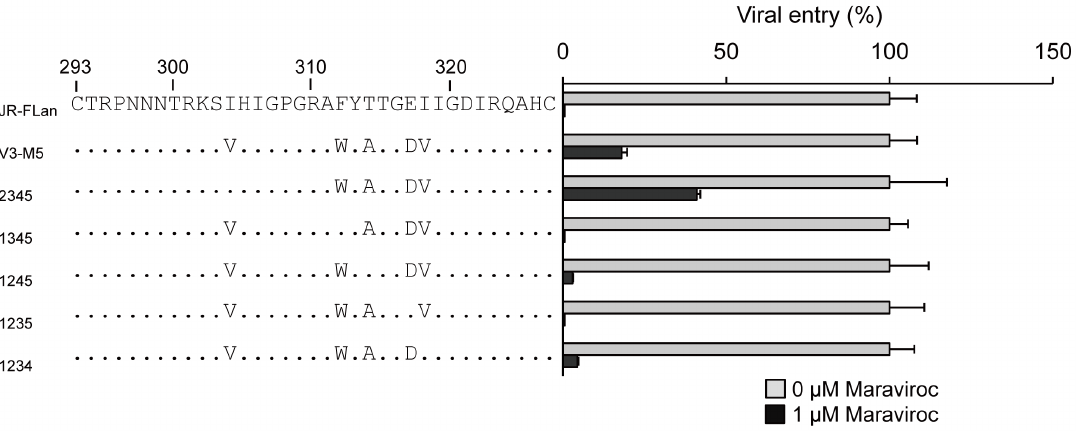
Figure 6. Maraviroc susceptibility of pseudotyped viruses derived from HIV-1 JR-FLan , HIV-1 V3-M5 , HIV-1 2345 , and HIV-1 1345 , HIV-1 1245 , HIV-1 1235 , and HIV-1 1234 . MAGIC-5 cells were infected with pseudotyped viruses in the absence or presence of 1 m M maraviroc. The analysis was repeated three times; the error bars represent the S.D. of three replicates from one representative experiment. **, p , 0.01. Statistical significant difference was calculated by t test.